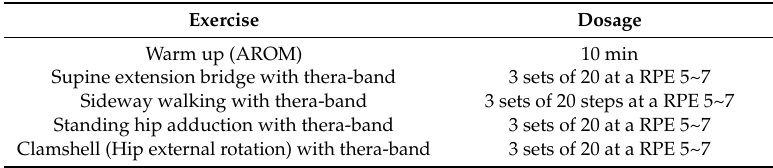
Table 1. Hip abductor and adductor muscle strengthening exercises.